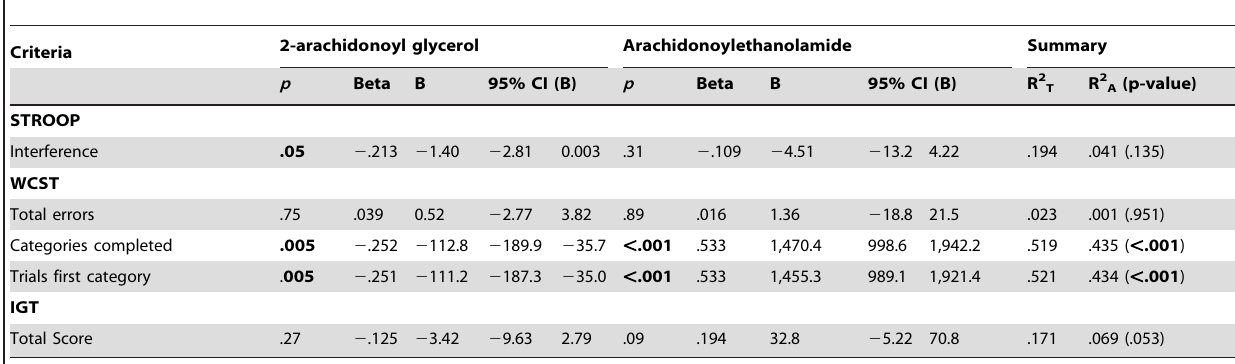
Table 3. Multiple regression models valuing the contribution of endocannabinoids on cognitive outcomes.